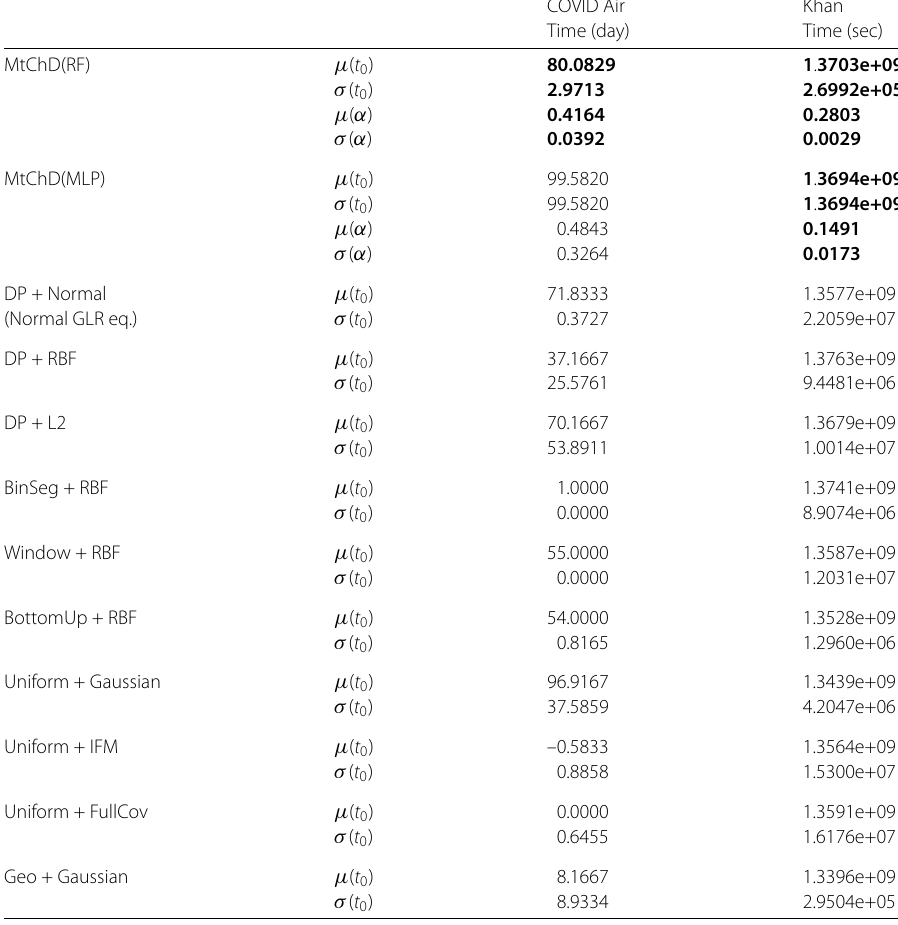
Table 3 A comprehensive comparison of our method with previous methods on real world datasets, COVID-19 Air and Khan Academy . We use the same abbreviations as in Table 1. For COVID-19 , the measure of t 0 is number of days since 01/01/2020. For Khan Academy , the measure of t 0 is Unix timestamp, namely, number of seconds since midnight 01/01/1970. Correct values are roughly 80 days for COVID-19 air data, and 1.365 × 10 9 seconds for Khan Academy data. Bold values indicate change points that are closest to the correct value COVID Air Khan Time (day) Time